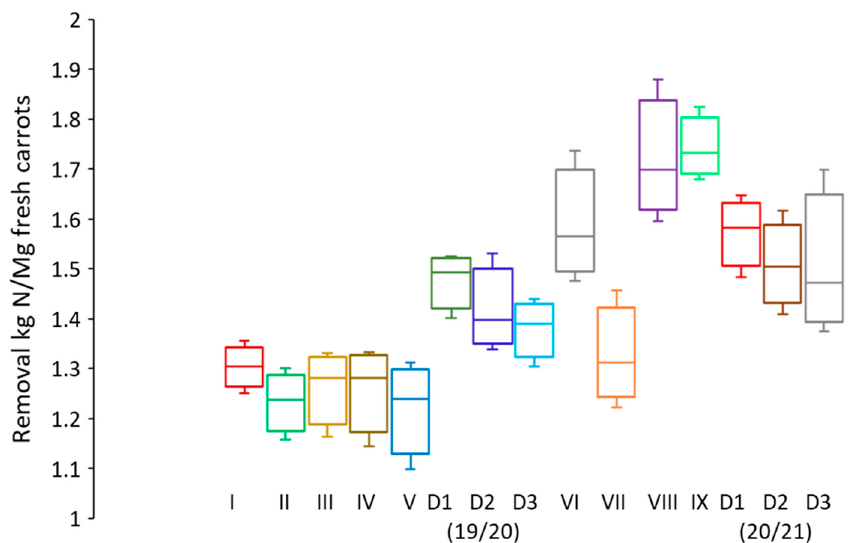
Figure 12. Removal N per fresh root weights at the experimental sites at harvest. The horizontal lines demonstrate the mean values, and the bars display the maximum and minimum values of removal N per fresh root weights. D1, D2, and D3 represent Sites DREC-1, DREC-2, and DREC-3, respectively.